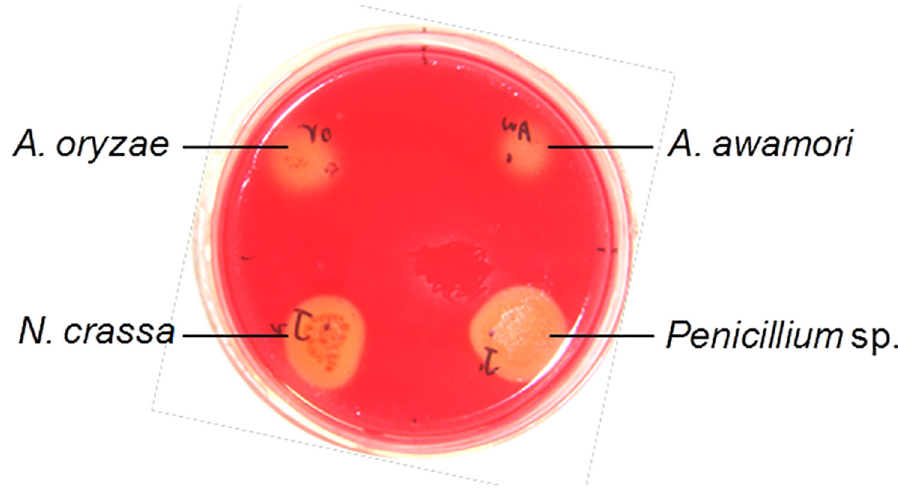
Fig 2. Congo red staining of fungal strains with cellulolytic activity. The fungal strains were grown on agar plate containing 1% (wt/vol) sodium carboxymethyl cellulose (CMC-Na) and 1.4% (wt/vol) agar. CMC hydrolysis was detected by the Congo red staining after being incubated for 3